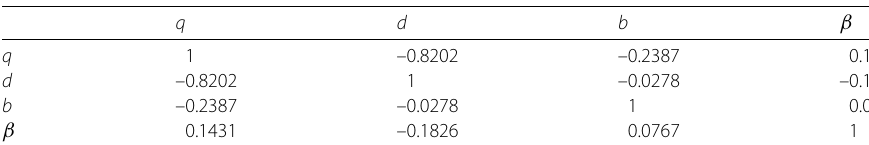
Table 2 The asymptotic parameter correlation matrix